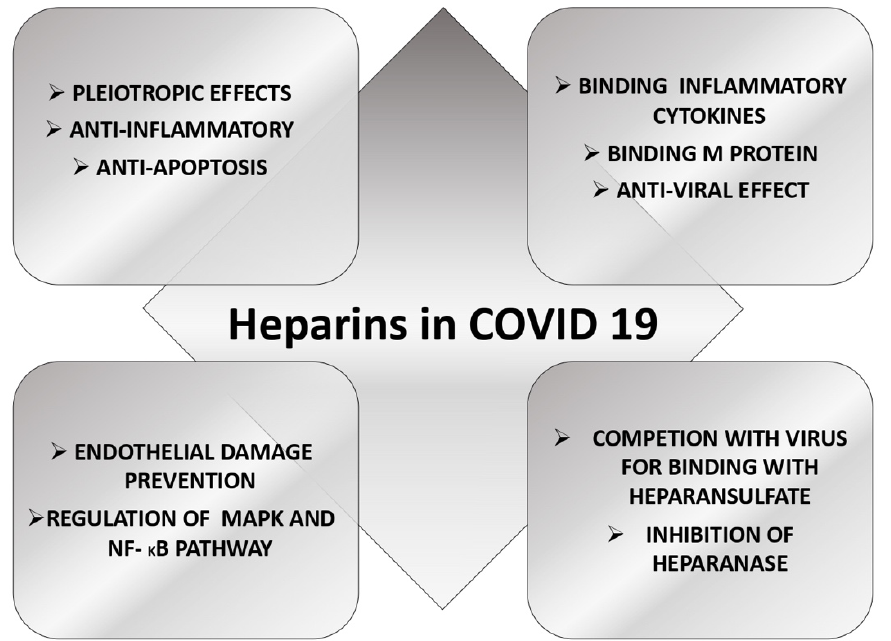
Figure 1. Potential therapeutic effects of heparin in COVID 19.